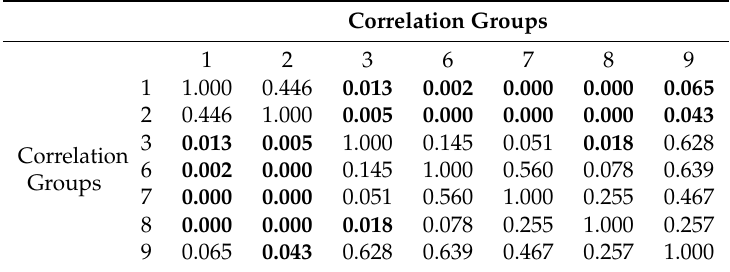
Table 5. p -values between the median results of variable V 9 “oxygen saturation” obtained from the spectra of the corresponding correlation groups.